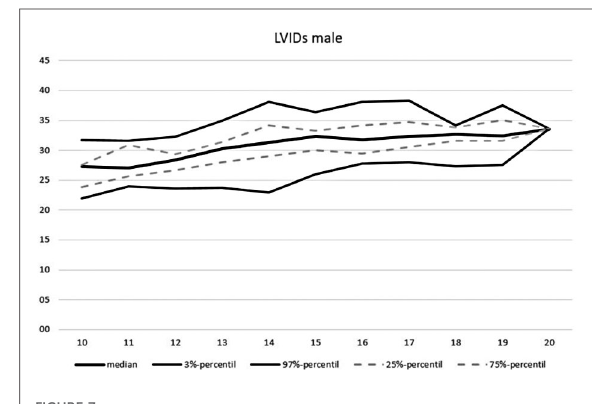
FIGURE 7 Echocardiographic values in dependence of age, LVIDs male.